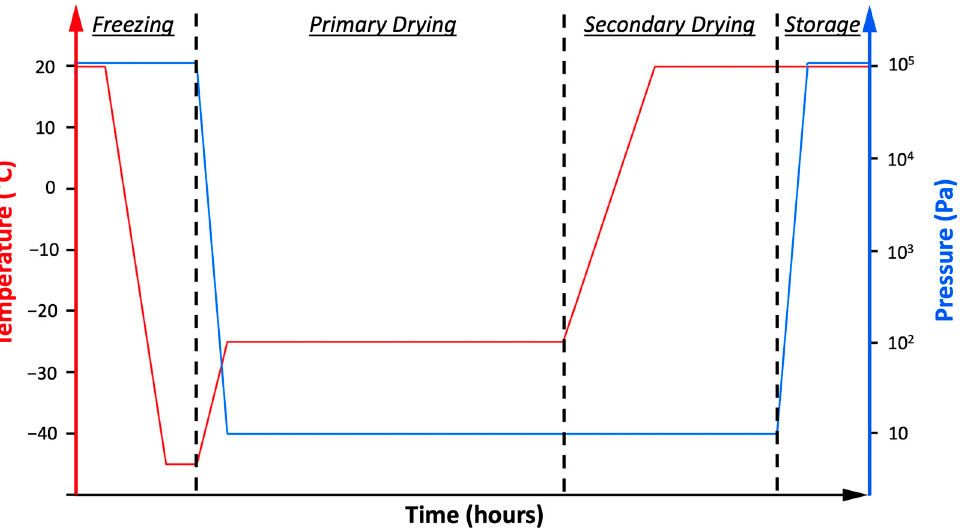
Figure 1. The graph represents the freeze-drying cycle. The red line represents the temperature variations and the blue one the pressure changes.